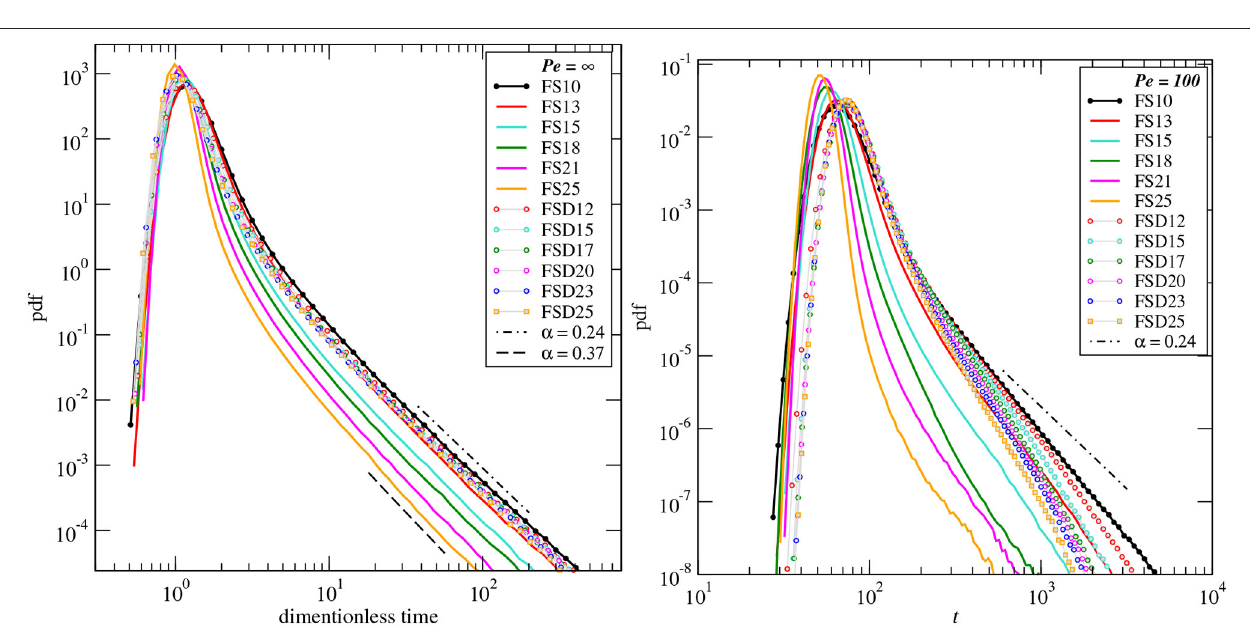
These values are in agreement with the value of 1.65